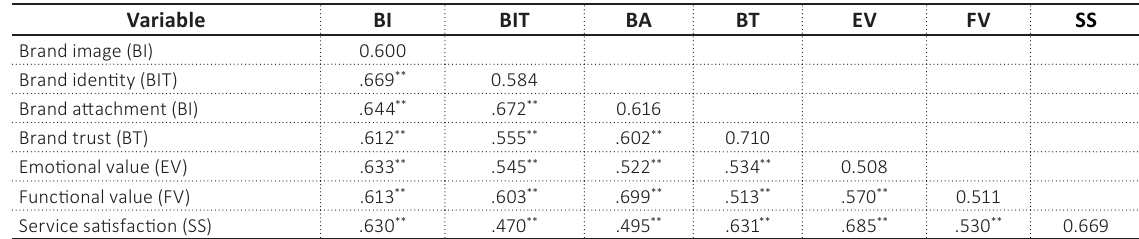
Table 3. Correlation matrix and AVE